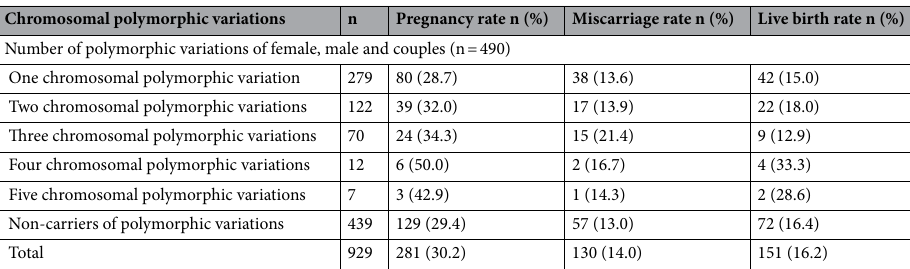
Table 6. Pregnancy, miscarriage and livebirth rates of the number of polymorphic variations in the study